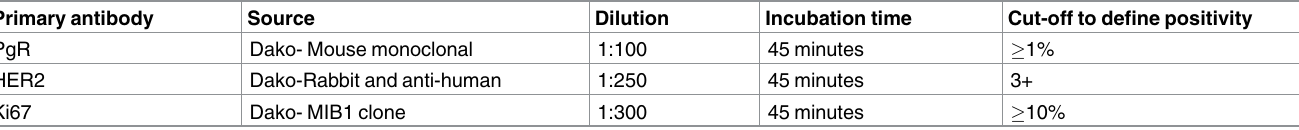
Table 1. Summaryof immunohistochemistry methodology for biological